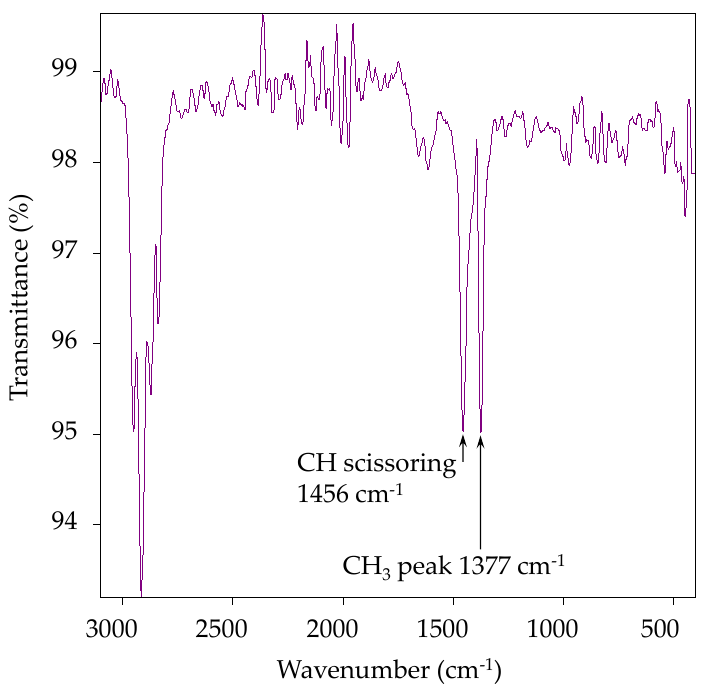
Figure 8. FTIR spectrum of a particle collected from sea salt identified as PP.